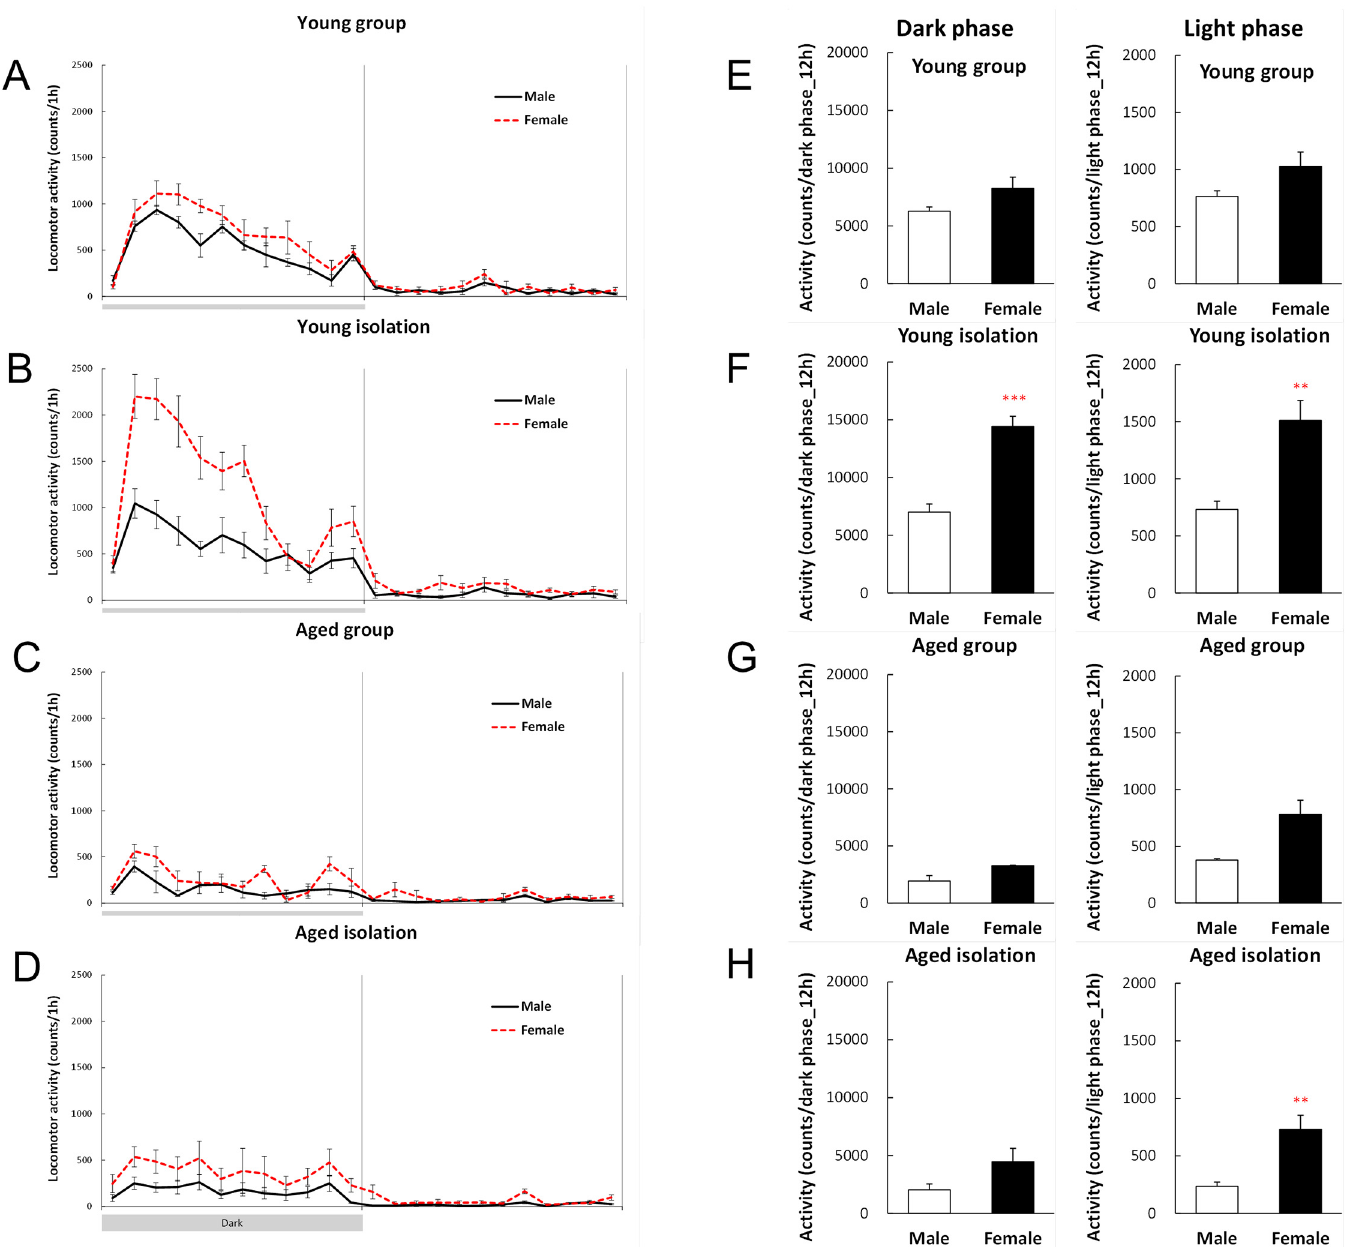
Fig 5. Locomotor activity levels after 2 weeks of isolation. The 24-h locomotor activity levels are shown for group-housed young mice (A), isolated young mice (B), group-housing aged mice (C), and isolated aged mice (D), as well as quantitative data for the locomotor activity levels (E – H). The data represent the mean ± SEM (Young group: n = 5, Young isolation: n = 8 – 9, Aged group: n = 3, Aged isolation: n = 6 – 7). ** , *** p < 0.01, 0.001 respectively vs. male